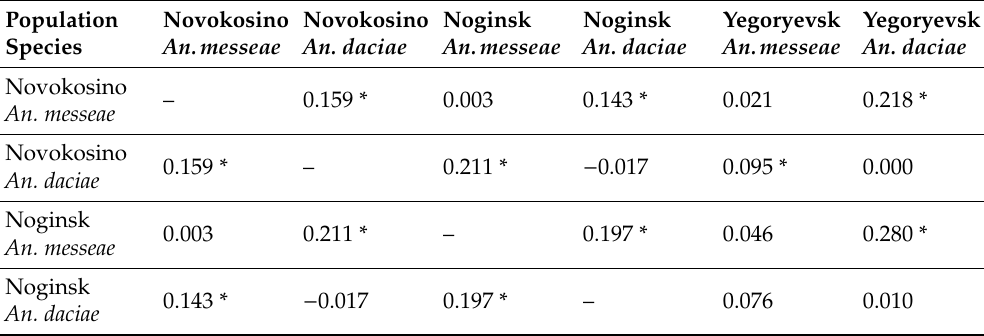
Figure 6. Interpopulation PCA plot based on the frequencies of the autosomal chromosomal inversions in three populations of An. messeae and An. daciae . Species are indicated by different colors. PCA analysis separates An. messeae and An. daciae along the PC1. Table 3. Pairwise Fst values between the studied populations of An. messeae and An. daciae based on the frequency of autosomal arrangements. *—results are significant with α < 0.05 after applied Bonferroni